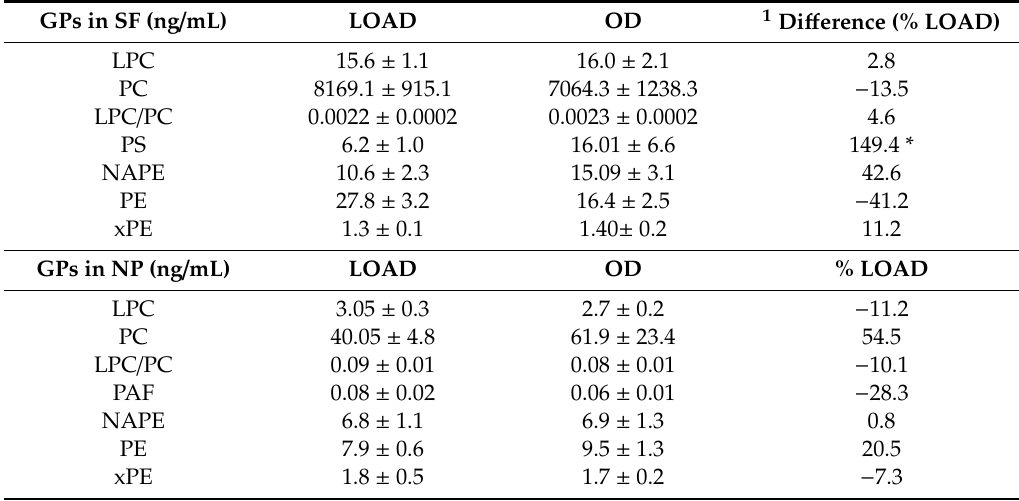
Table 3. Glycerophospholipids (GPs) in supernatant fluid (SF) and nanoparticle (NP). GPs in SF (ng / mL)